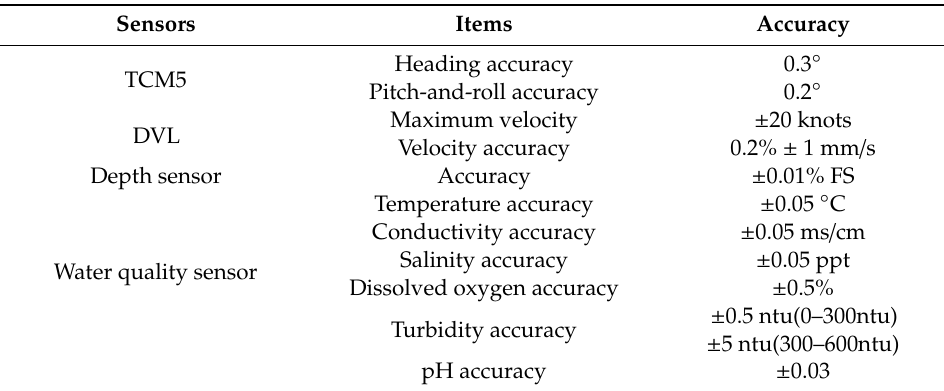
Table 2. Specifications of the applied sensors.